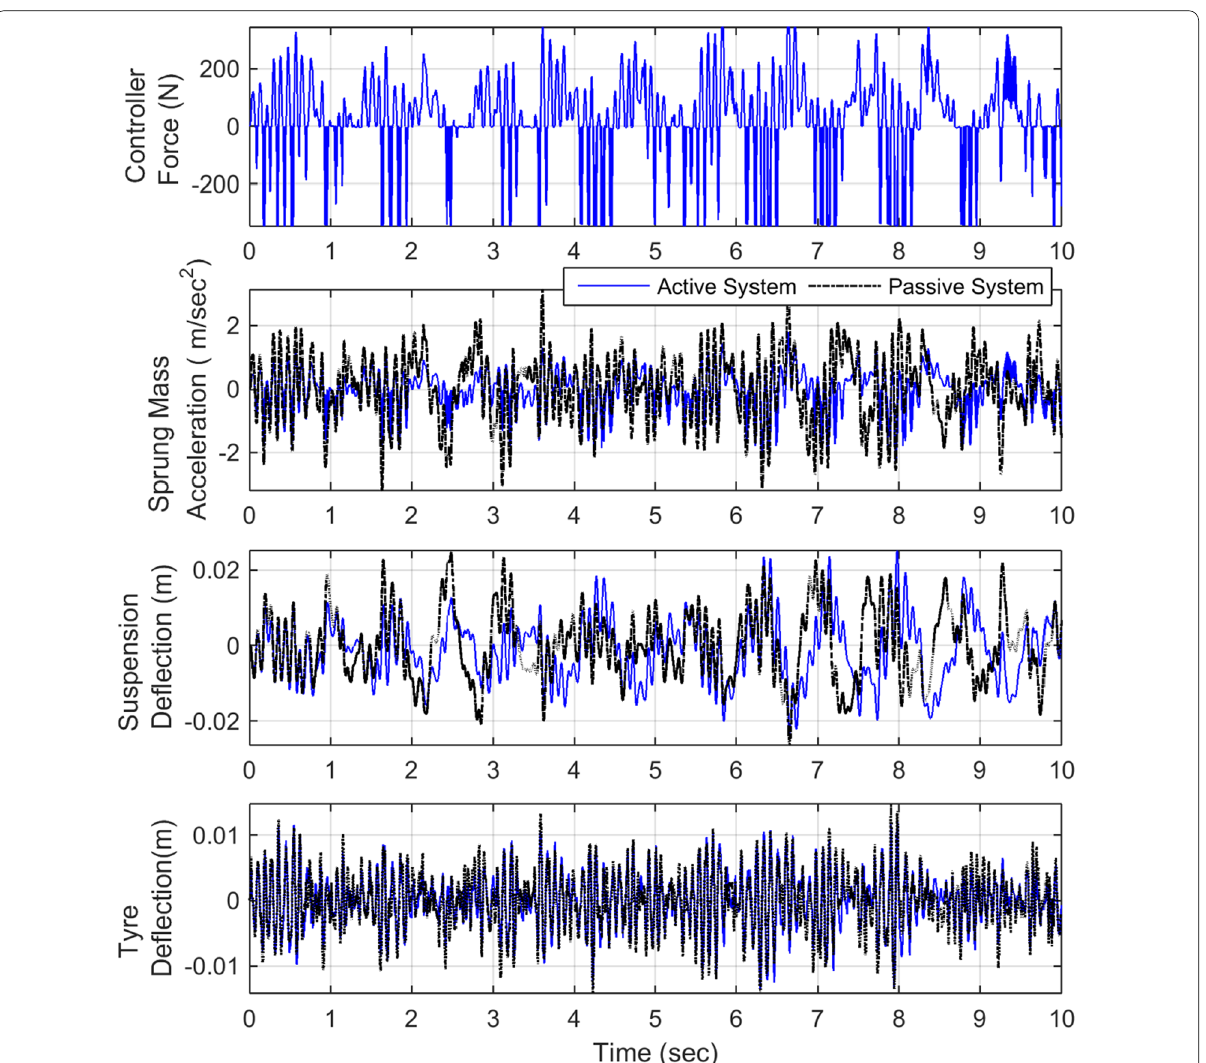
Fig. 7 Fuzzy logic control results of the initial passive and initial active suspension system—time domain